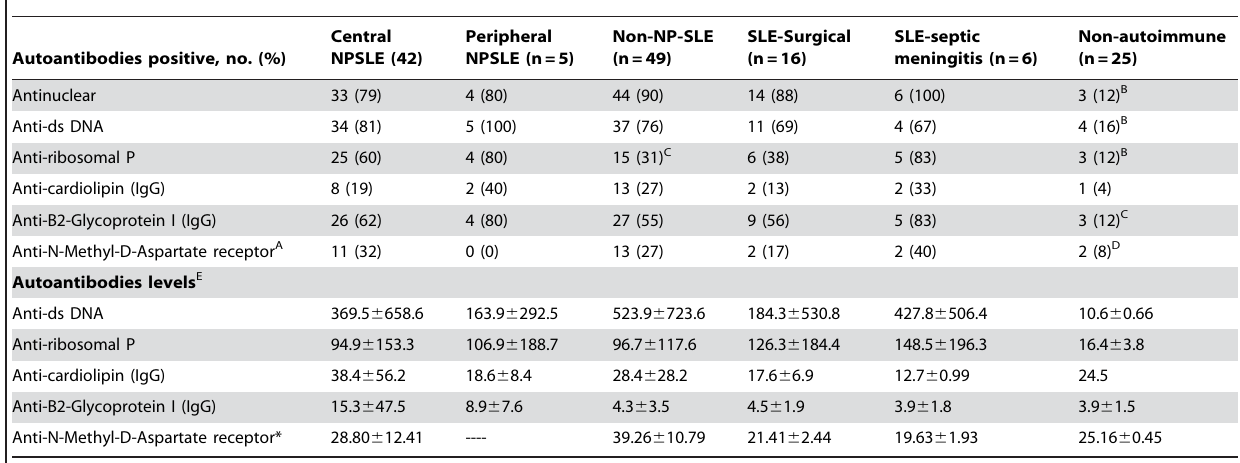
Table 2. Prevalence and levels of autoantibodies in serum from NPSLE patients and controls.